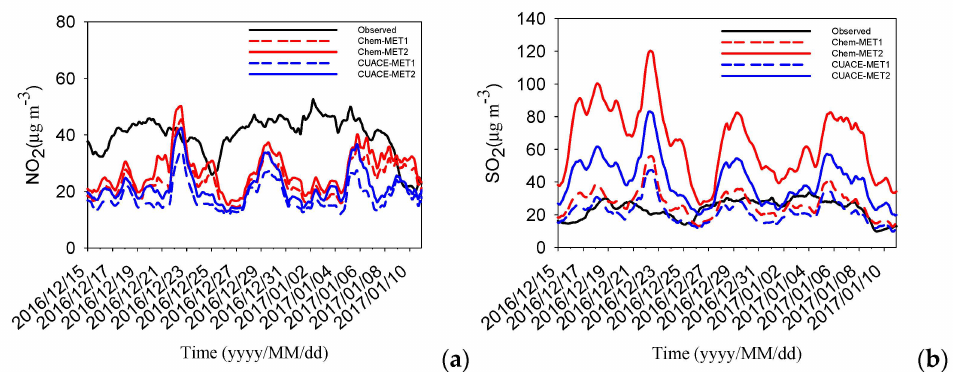
Figure 10. Time series of daily averaged observed (black solid lines) and simulated NO 2 concentra- tions ( a ), observed and simulated SO 2 concentrations ( b ) of the four tests (red dotted line: Chem- MET1; red solid line: Chem-MET2; blue dotted line: CUACE-MET1; blue solid line: CUACE-MET2). (unit: µ g m − 3 ).